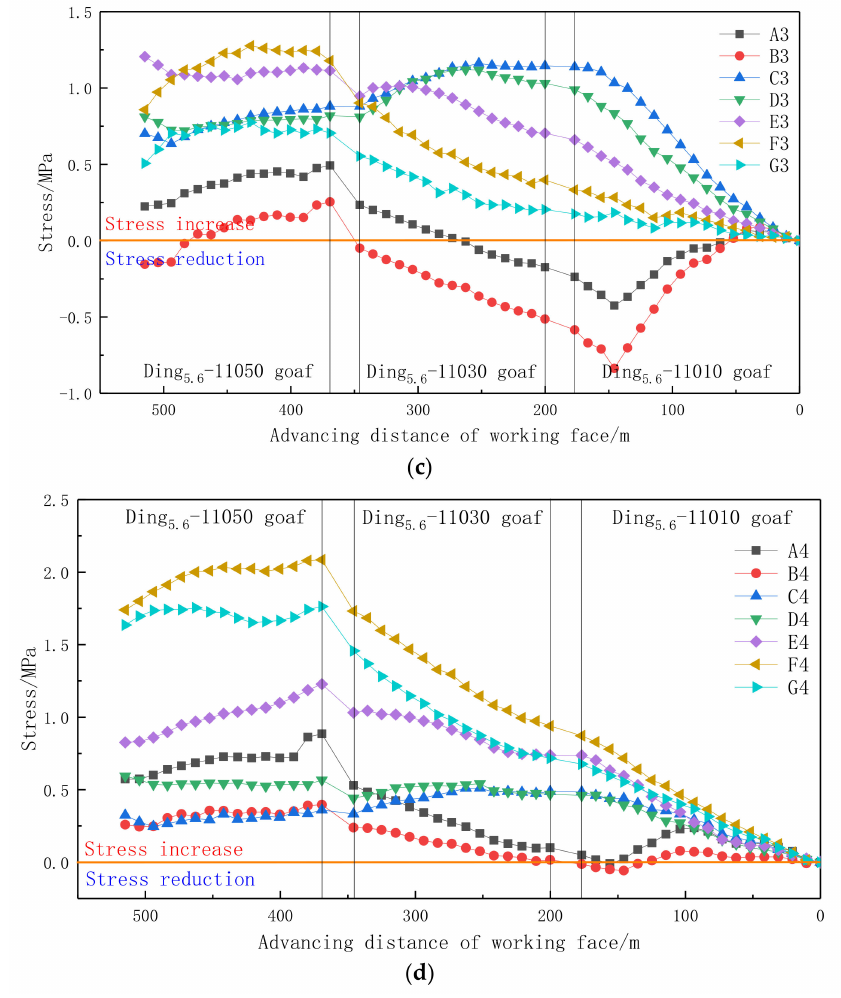
Figure 9. Stress evolution law of different layers of floor during the mining of Group D coal seam: ( a ) Evolution law of floor 33 m stress in the mining process of Group D coal seam; ( b ) Evolution law of floor 87 m stress in the mining process of Group D coal seam; ( c ) Evolution law of floor 182 m stress in the mining process of Group D coal seam; and ( d ) Evolution law of floor 260 m stress in the mining process of Group D coal